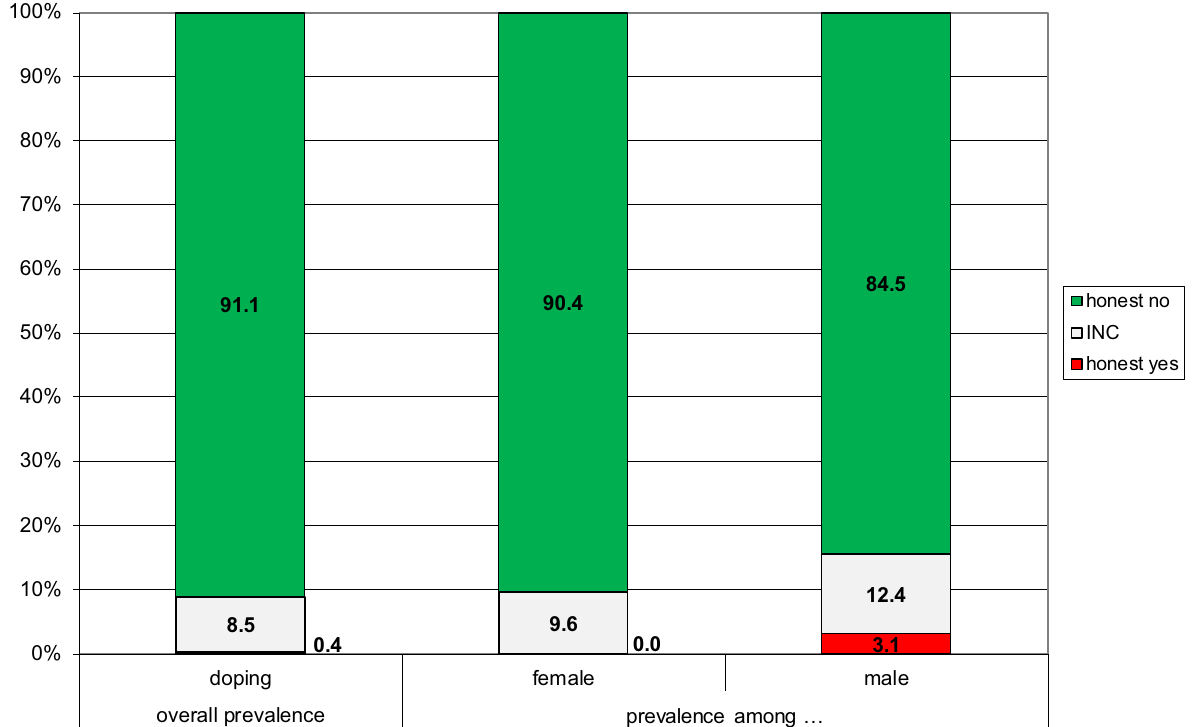
Fig. 5 Estimates for the prevalence of dopers in the overall population and among females and males. INC